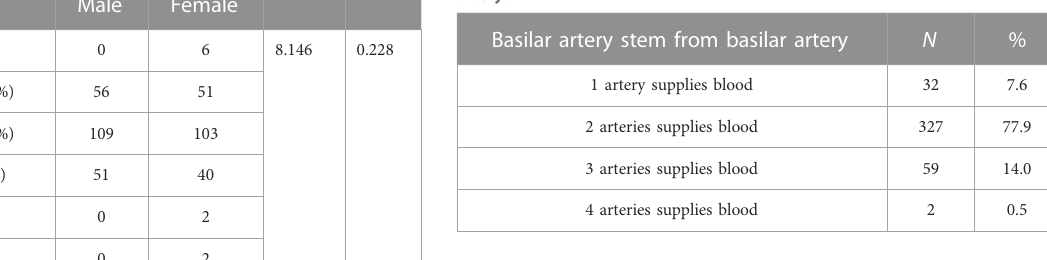
TABLE 4 Distribution characteristics of the right superior lobar pulmonary artery.